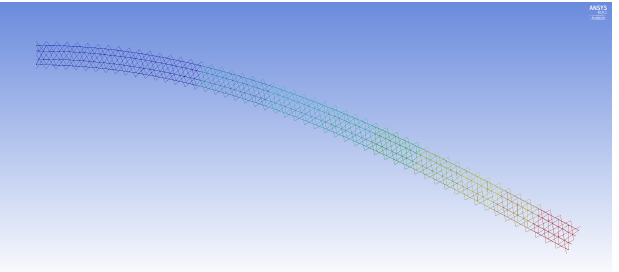
Figure 3. Global buckling of an inner longitudinal IsoTruss structure [26].